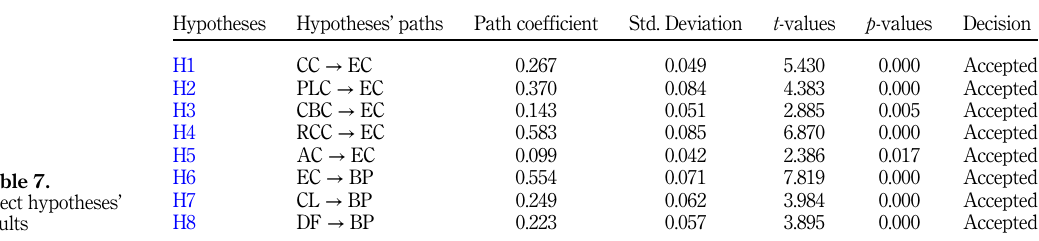
Table 6. Discriminant validity (Fornell – Larcker)